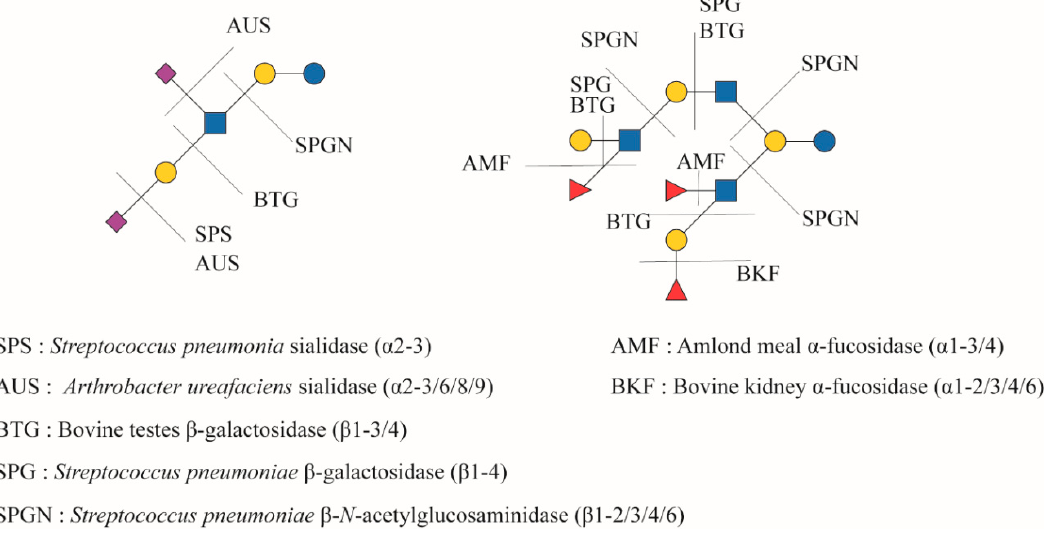
Figure 3. Overview of a suitable set of readily available exoglycosidases most relevant to hMOS analysis